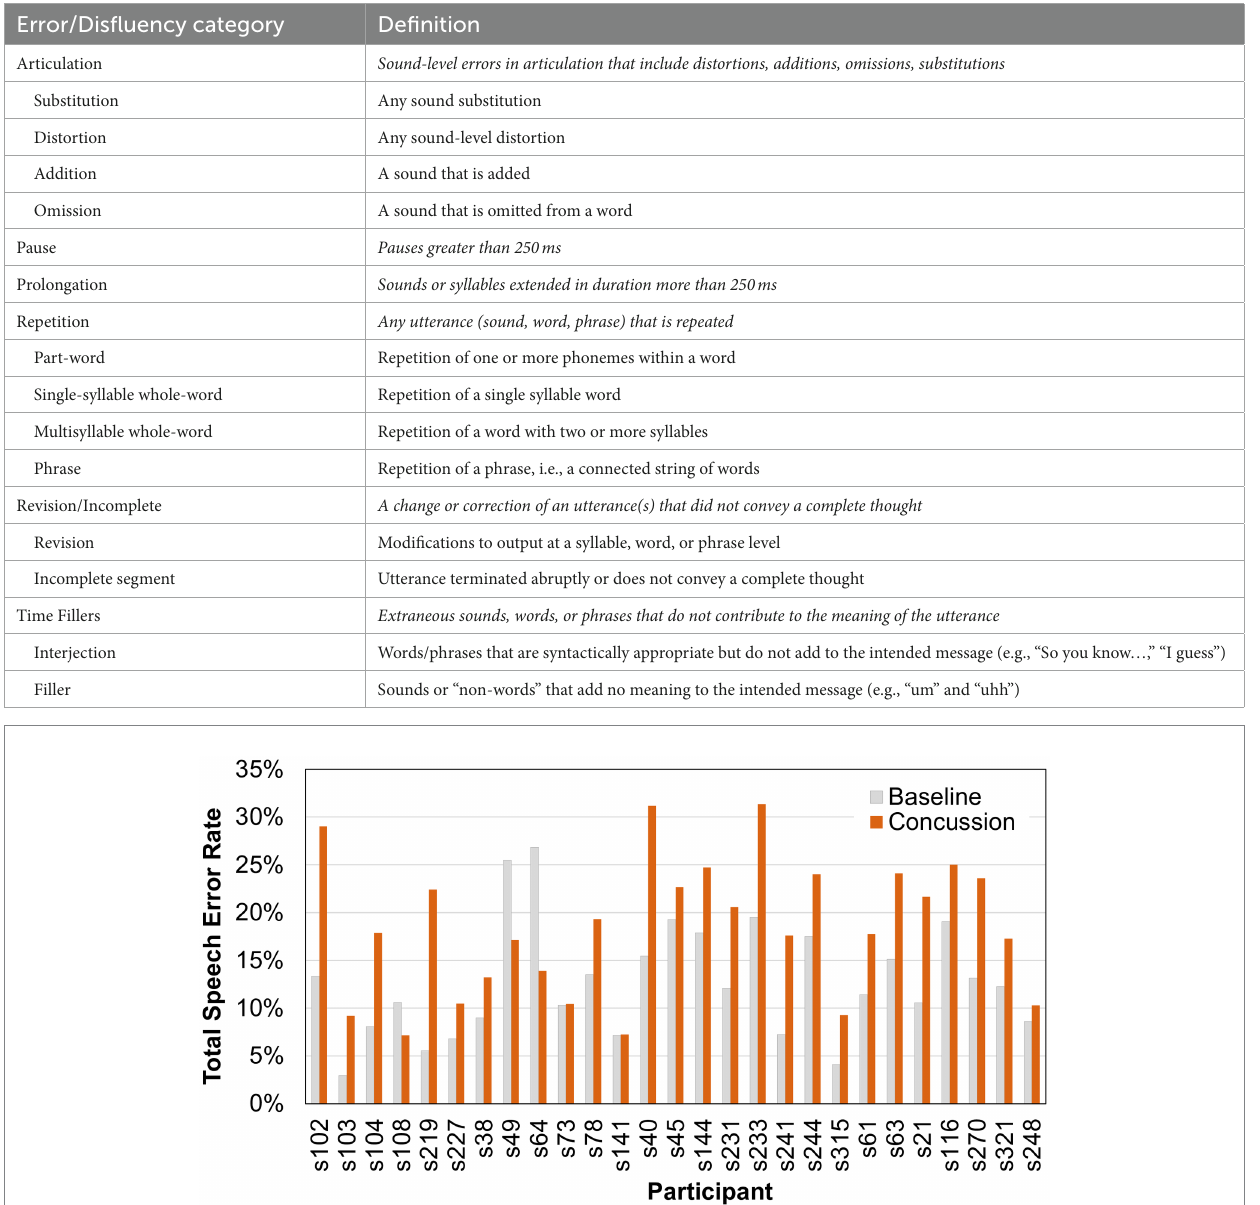
TABLE 2 Coding criteria for speech errors and disfluencies within six major error categories.